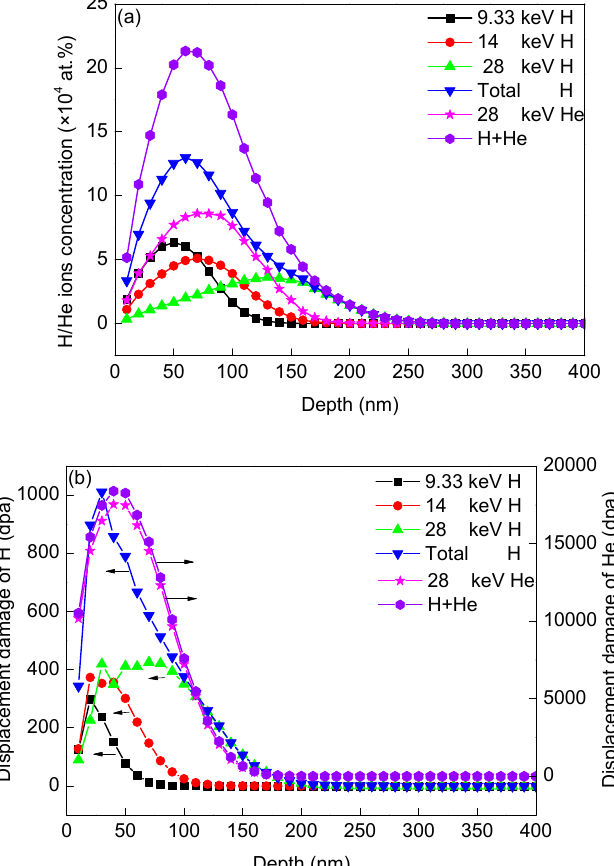
Figure 1. SRIM simulation results of ( a ) H and He concentration-depth profiles in CVD-W and ( b ) the corresponding displacement damage-depth profiles.